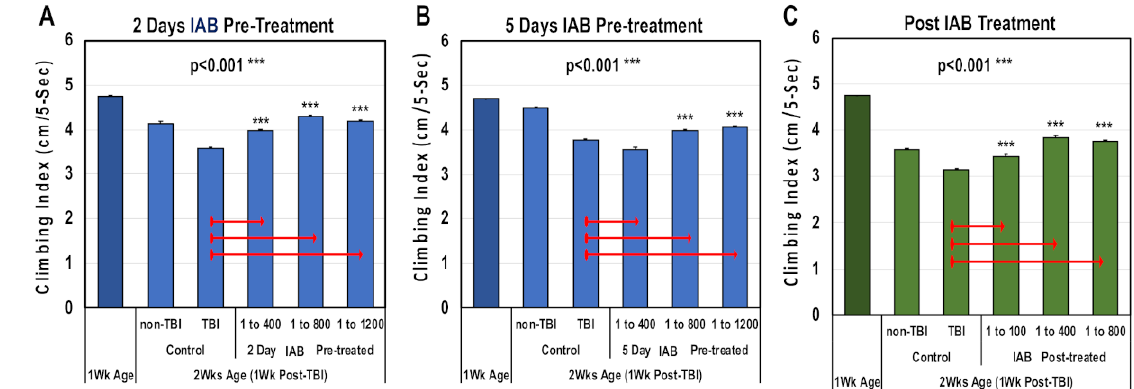
Figure 3. The negative geotaxis responses (NGRs) of young Drosophila before and after trauma. Geotaxis responses of flies before and after ( A ) two days or ( B ) five days of IAB pretreatment (0.0, 1:400, 1:800, 1:1200) and one week following mild traumatic brain injury or mTBI-10 × . ( C ) The NGR profiles of flies exposed to mTBI-10 × and post-treated with IAB (0.0, 1:100, 1:400, 1:800). ( p values *** < 0.001). See Supplementary Table S2A–C for fly numbers ( n ) and additional